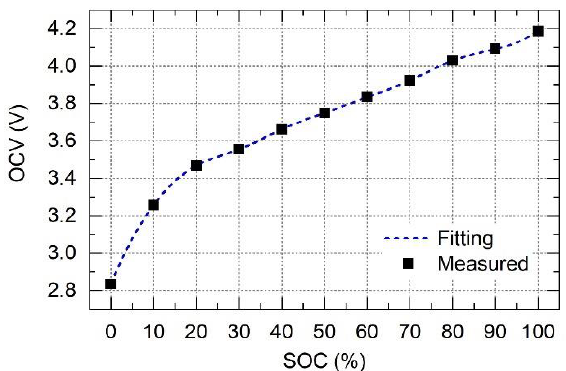
Figure 6. ( a ) Battery pulse discharge test profile; ( b ) open-circuit voltage for each SOC.